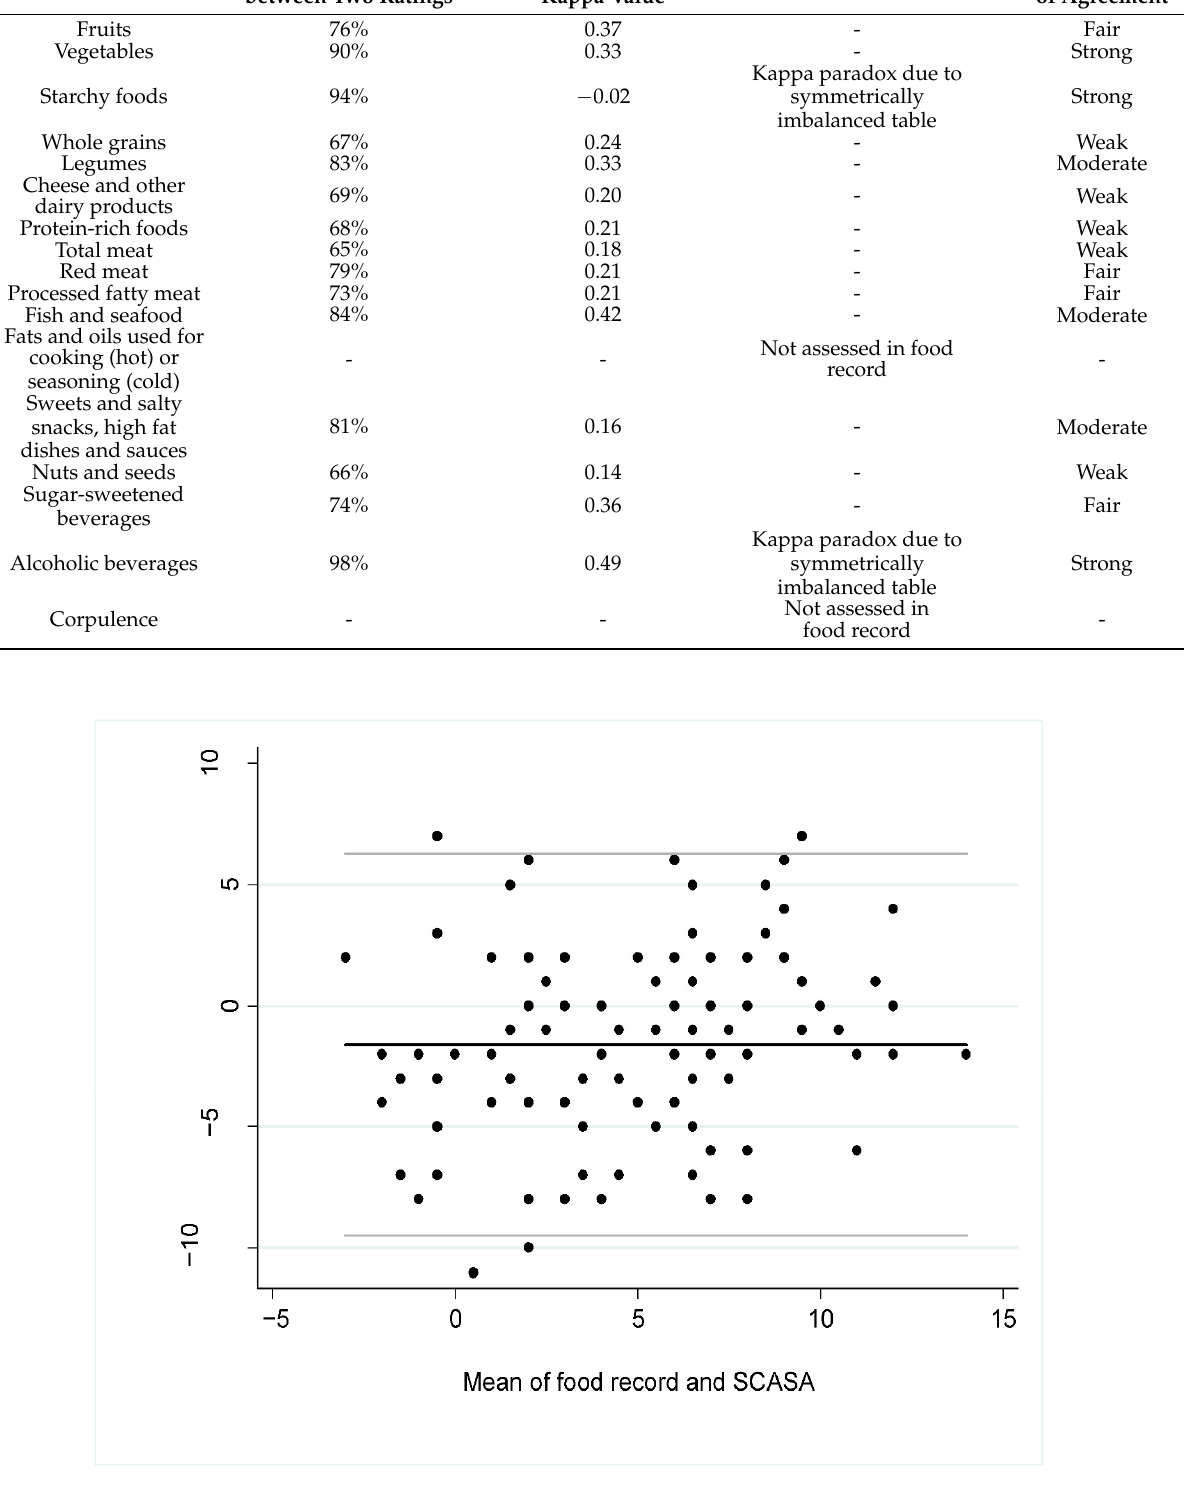
Figure 3. Bland–Altman plot for overall agreement between the total score obtained with SCASA (Score d’Alimentation Saine) and with the 5-to-7-dayfood record (i.e., reference method) ( n = 105). The black line represents the mean bias between the two measures and the grey lines are the 95% limits of agreement.